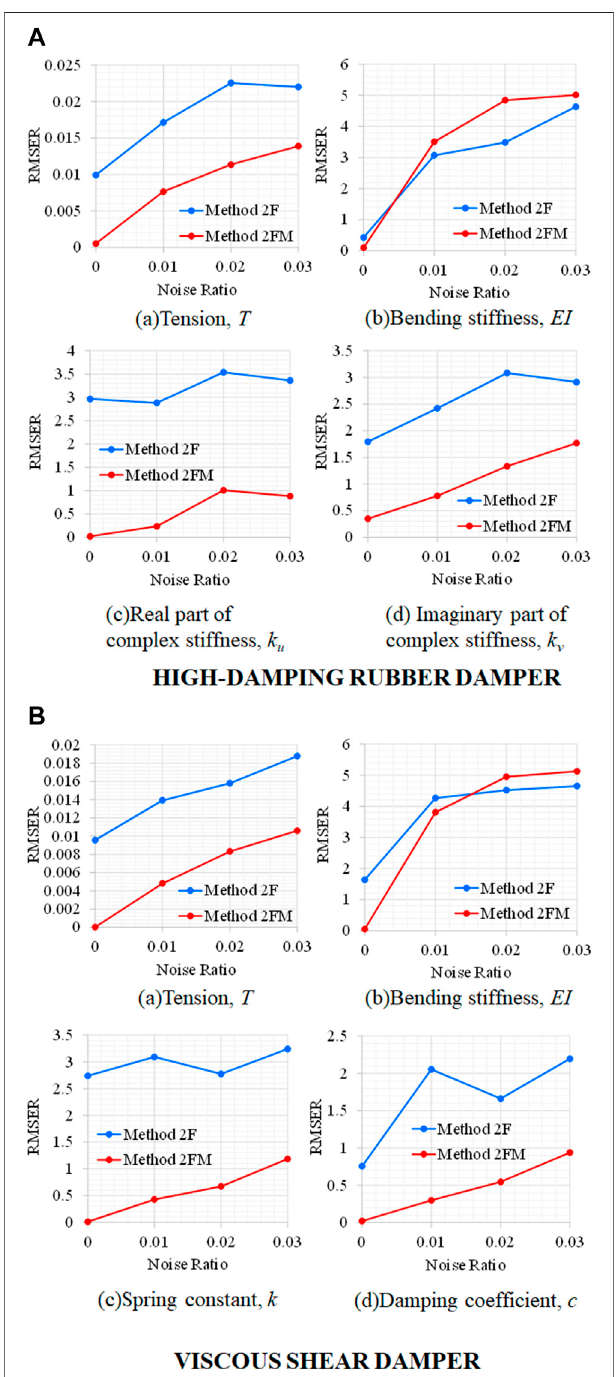
FIGURE6| RMSERofestimationresultsforvariousmeasurementnoise ratios: (A) high-damping rubber damper; (B) viscous shear damper.